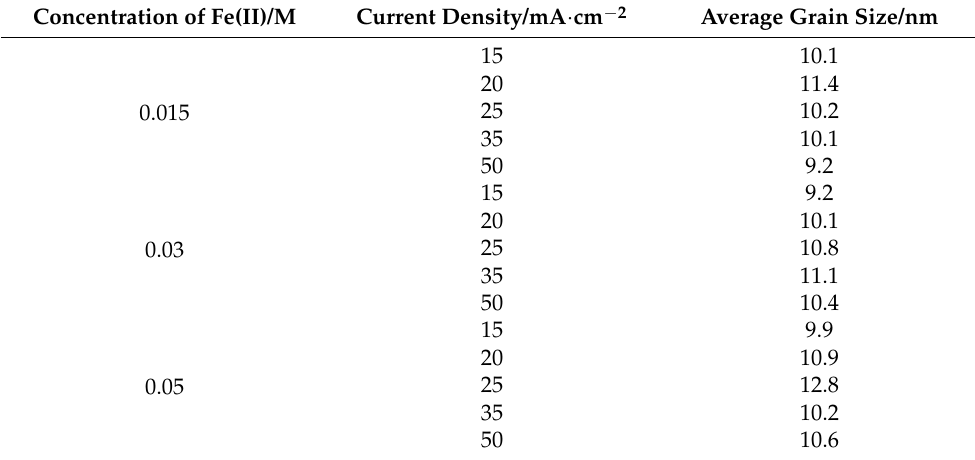
Table 2. Average grain sizes of FeNi electrodeposited films.